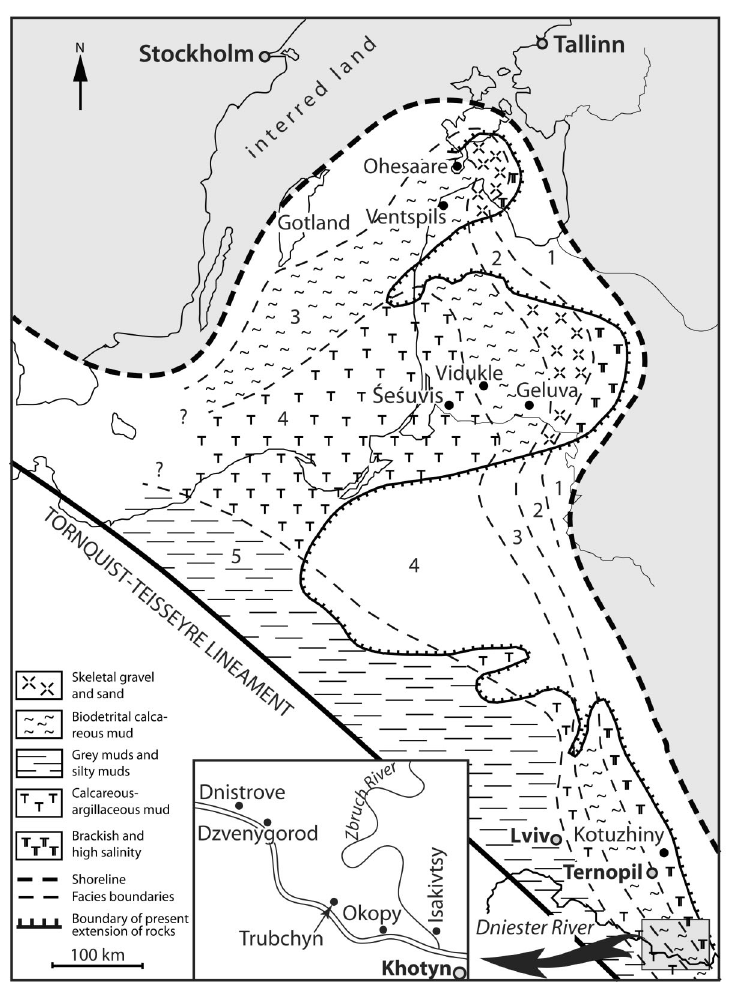
Fig. 1. Location of the studied sections and general facies zonation of the West Baltica marginal sea basin during early P ř (cid:237)dol(cid:237) time. Modified from Einasto et al. (1986) and Bassett et al. (1989). Facies belts (signature shows presence of sediments, white areas (cid:150) postsedimentary erosion or no data): 1, tidal-flat(cid:150)lagoonal; 2, high-energy shoal-bar; 3, open shelf, mid-ramp; 4, offshore shelf, outer ramp; 5, ramp/shelf